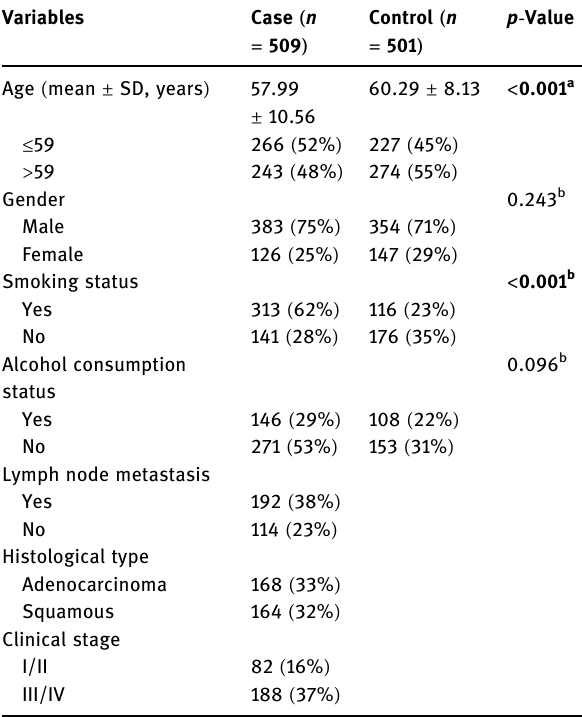
Table 1: Demographic and clinical characteristics of